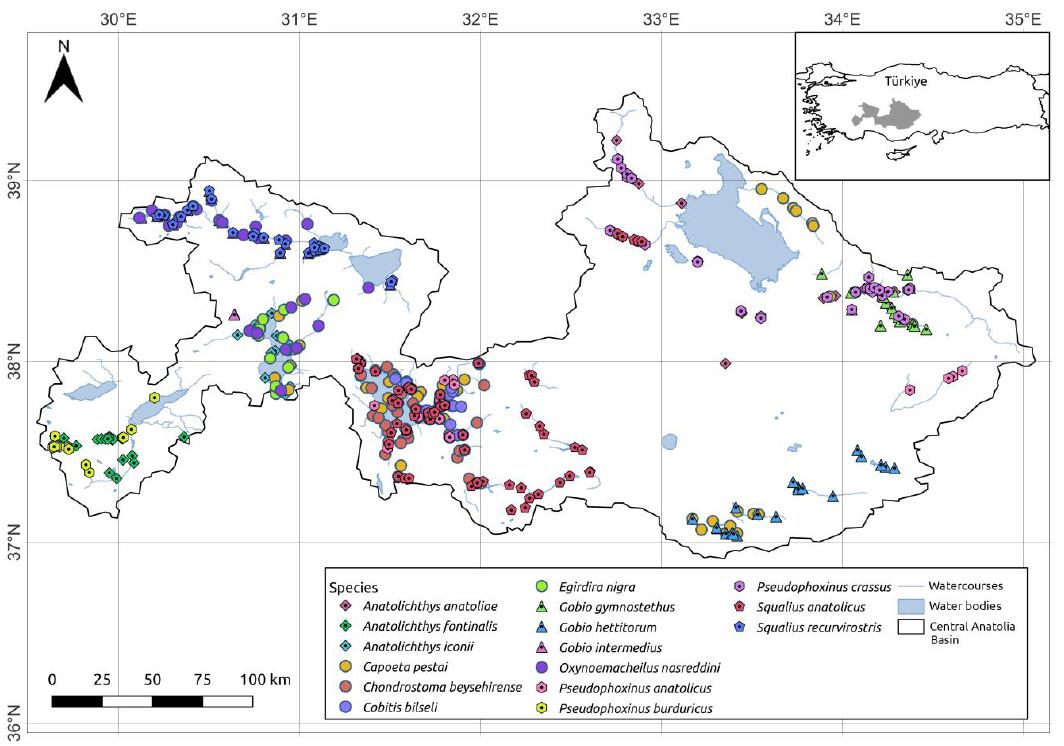
Figure 1. Distribution records of the studied species and their locations in the Central Anatolia Ecoregion in Türkiye. Ecoregion in